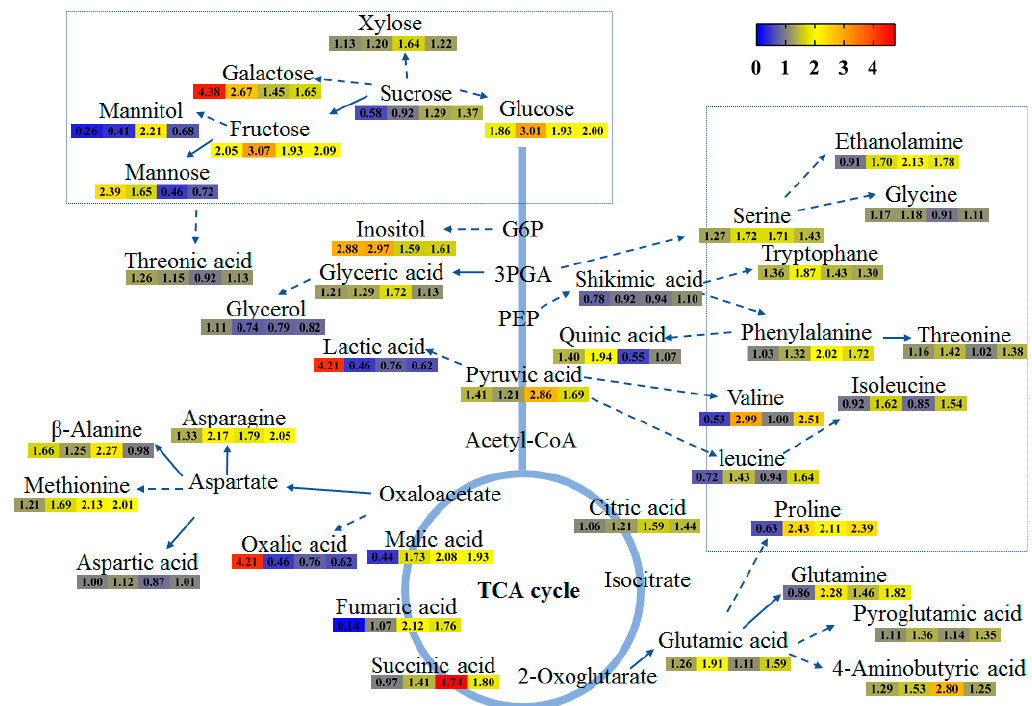
Figure 5. Overview of the primary metabolic changes of buckwheat in response to salt stress. The fold changes of each metabolite are given by salt-treated relative to control group in 1, 2, 4 and 5 day (cells from left to right, respectively). Different colors (from red, orange, yellow, grey yellow to blue) represent the fold change of the metabolites as indicated in the legend.